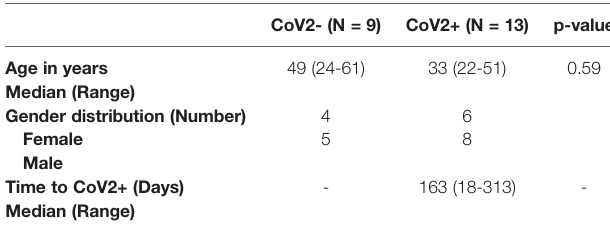
TABLE 1 | Demographic and clinical variables in study